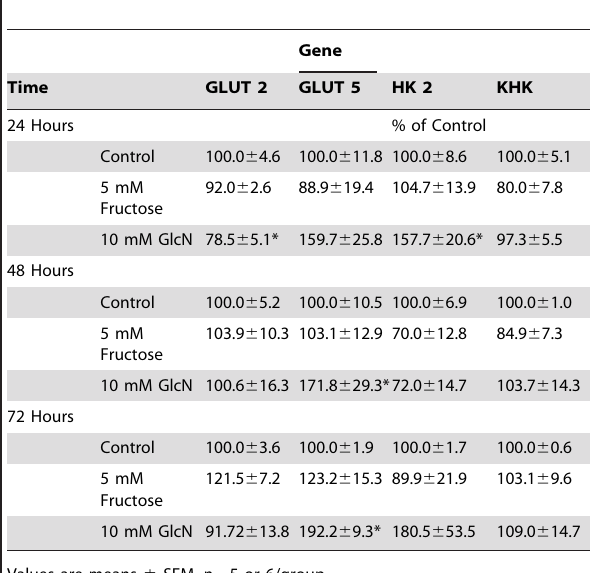
Table 2. mRNA expression of carbohydrate transporters and catabolic enzymes in HepG2 cells cultured in standard MEM (control, containing 5.5 mM glucose), MEM + 5 mM fructose, or